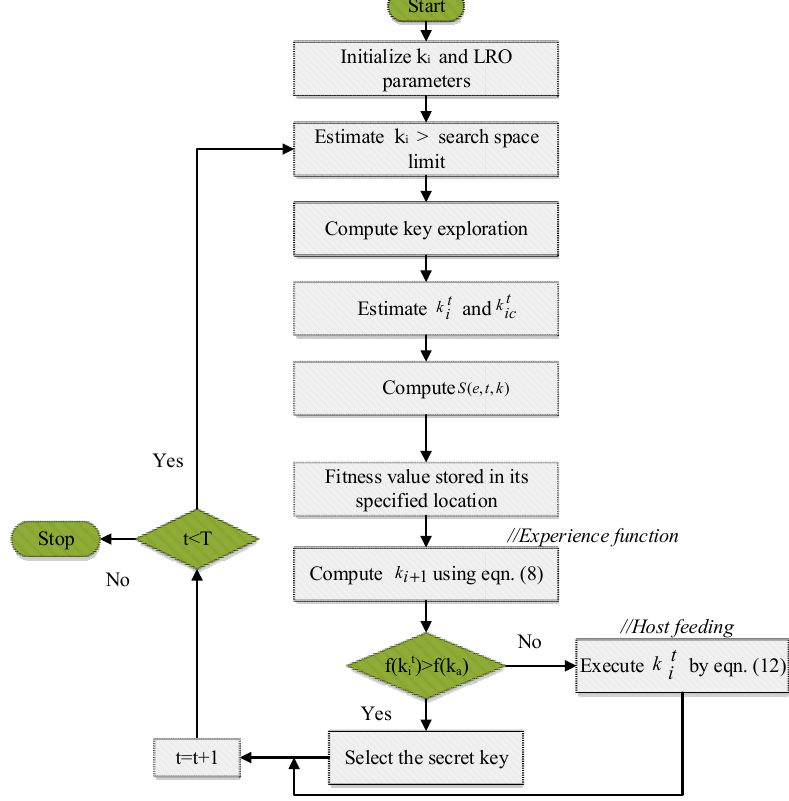
Figure 2. Flowchart of the LRO algorithm.